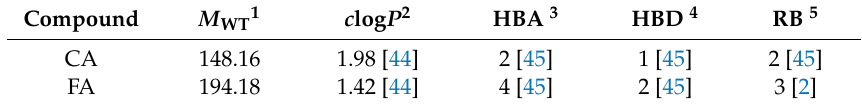
Table 3. Drug-like properties of CA and